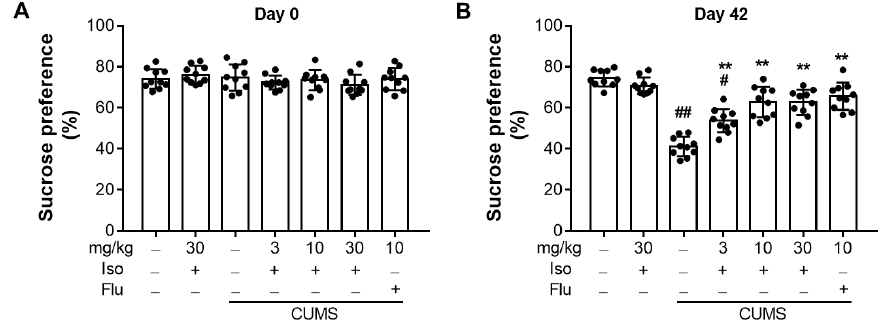
Figure 3. Isofraxidin restores CUMS-induced decrease in sucrose consumption. ( A ) Baseline sucrose consumption ratio at Day 0. ( B ) Sucrose consumption at Day 42. Data are presented as means ± SEM ( n = 10). The Control group was CUMS-free mice administered with normal saline. CUMS group was CUMS mice. Significance was analyzed by one-way ANOVA followed by the Bonferroni correction. # p < 0.05 and ## p < 0.01, compared with the control group. ** p < 0.01, compared with CUMS group.